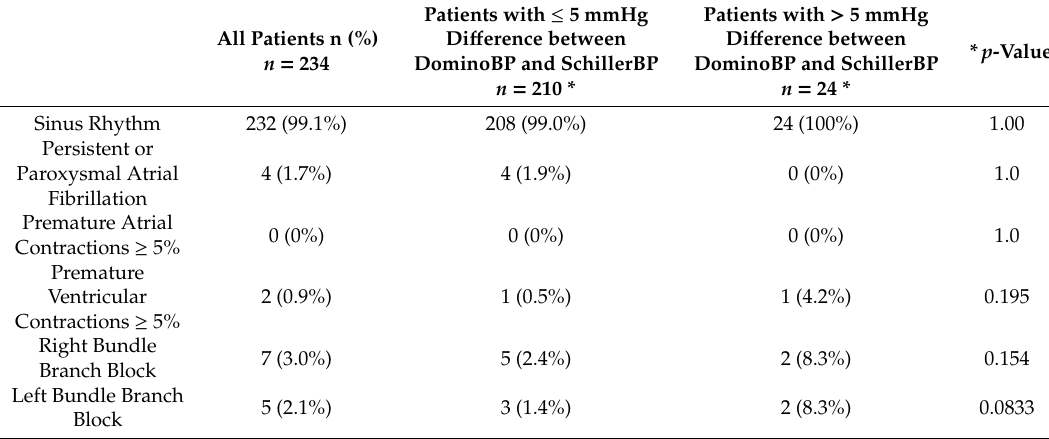
Table 3. Electrocardiographic (ECG) characteristics of all patients, and solely patients with > 5 mmHg di ff erence between DominoBP and SchillerBP.